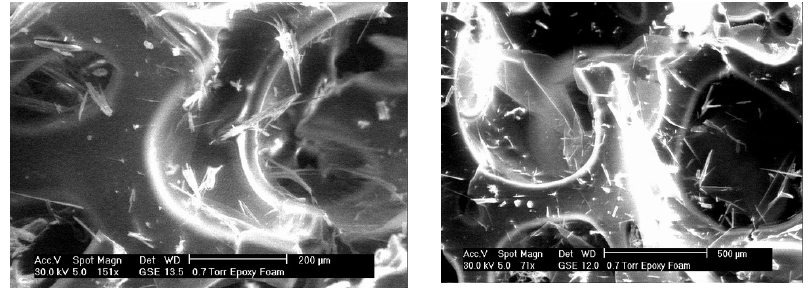
Figure 5a . SEM micrograph of modified epoxy foam.